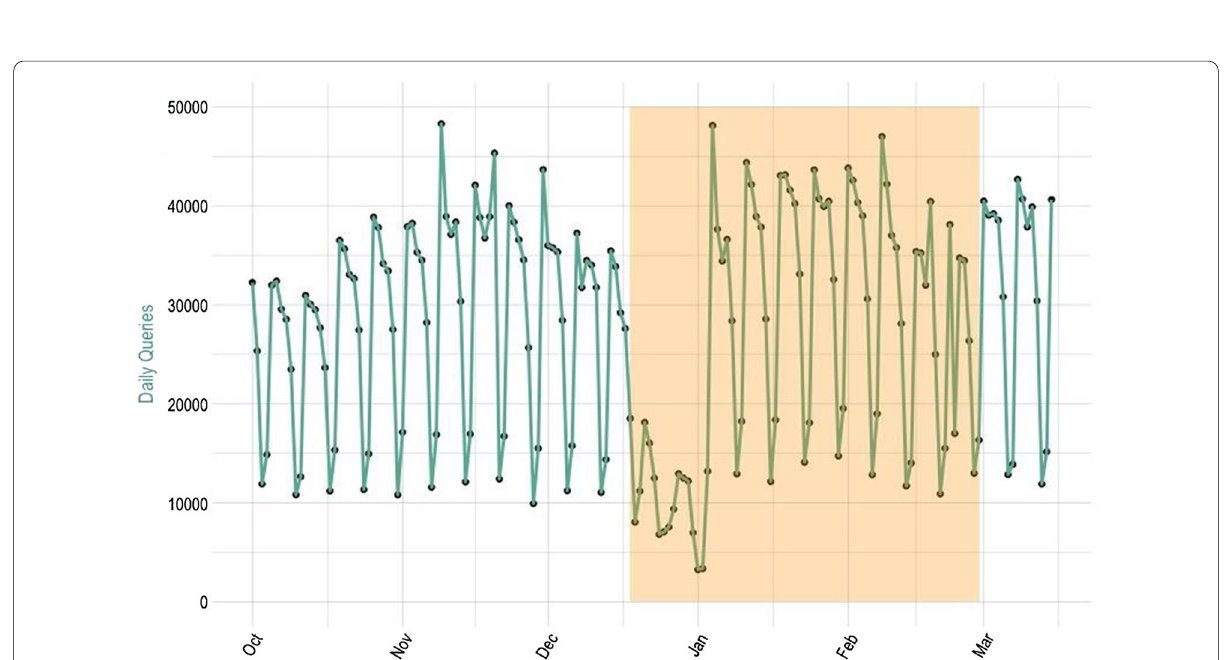
Fig. 8 Second shutdown, daily queries, Oct 01, 2020–Mar 15, 2021. Green solid line connects for illustration purposes the daily queries (black points). Yellow shaded area represents the time between 22.12.2020 and